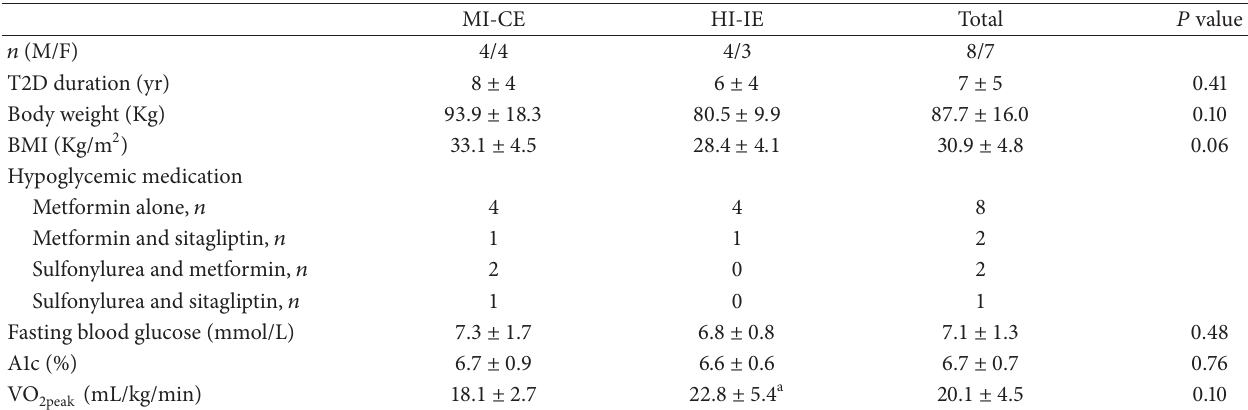
Table 1: Baseline characteristics.